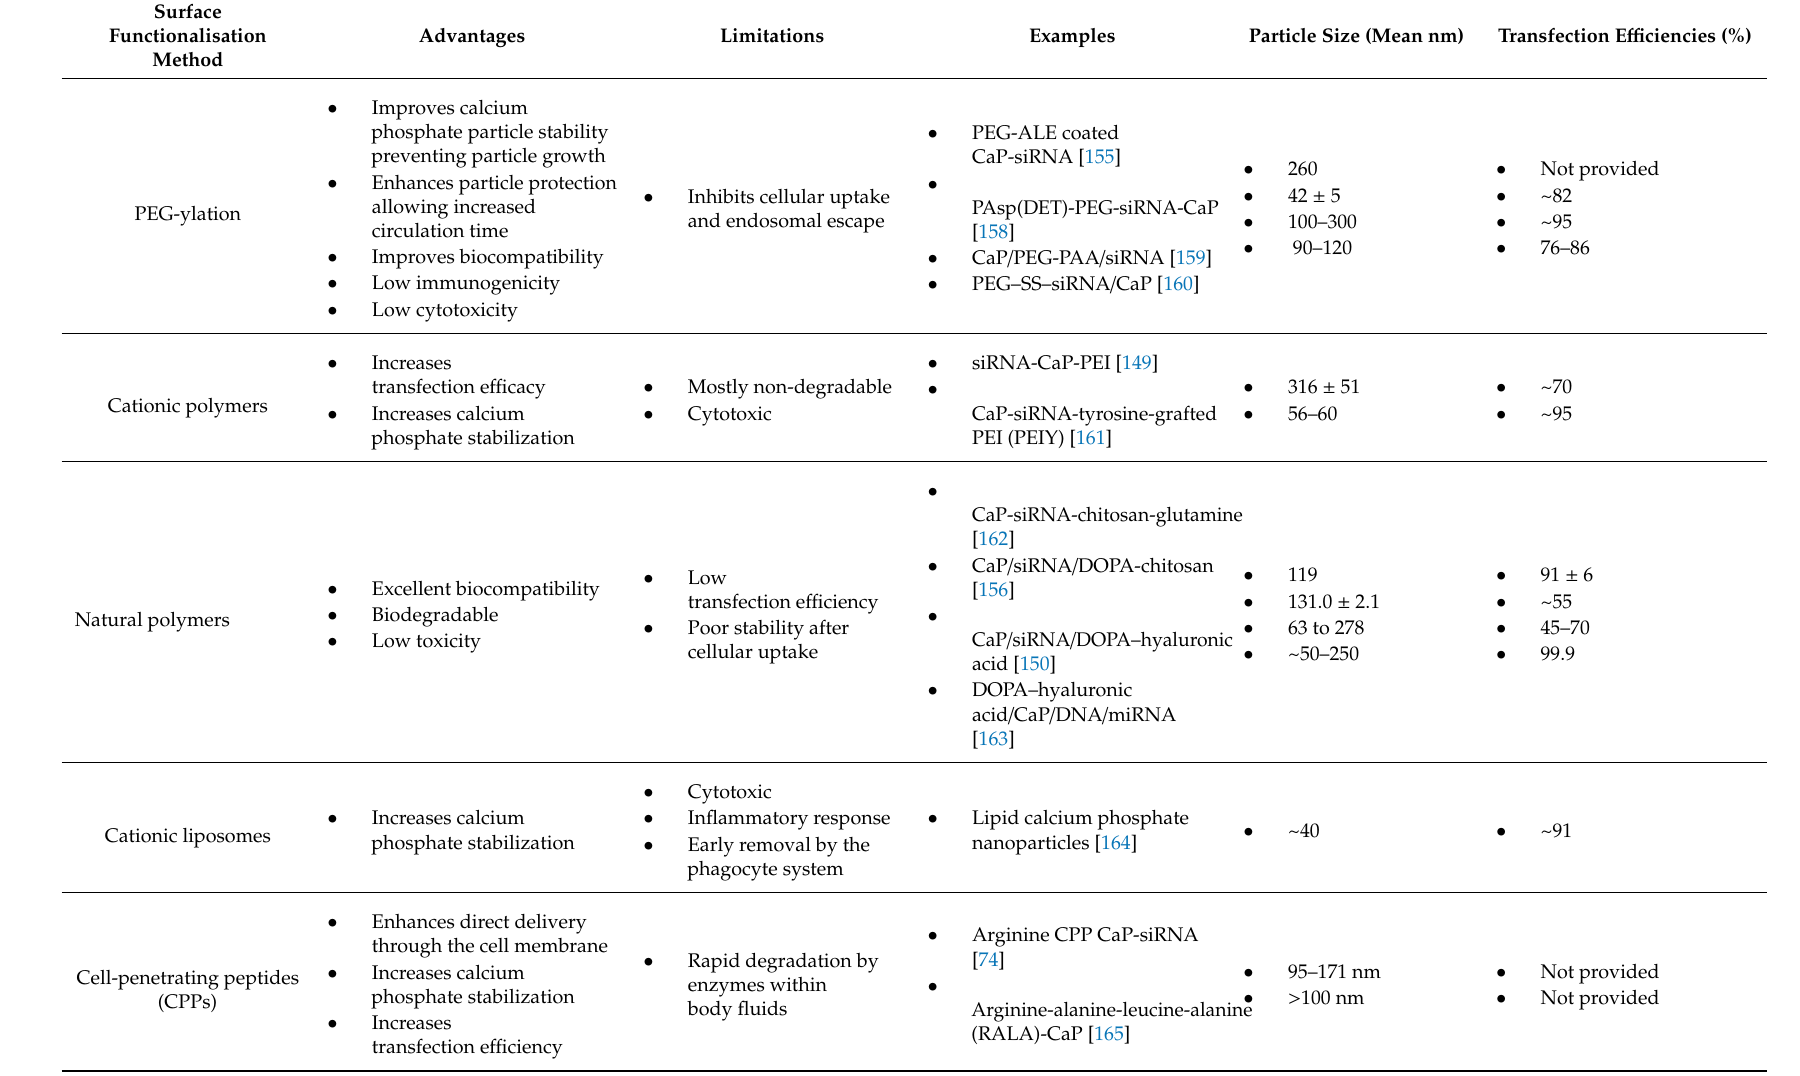
Table 2. Advantages and limitations of calcium phosphate nanoparticle surface functionalisation